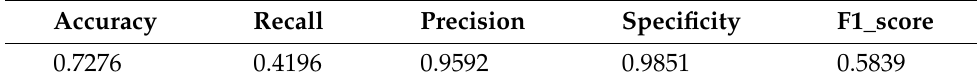
Table 13. Metrics for Ensemble without clusters.